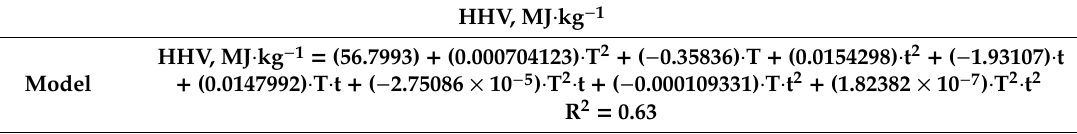
Table A5. The statistical parameters of polynomial regression analysis of the influence of SS torrefaction temperature and residence time on HHV of the